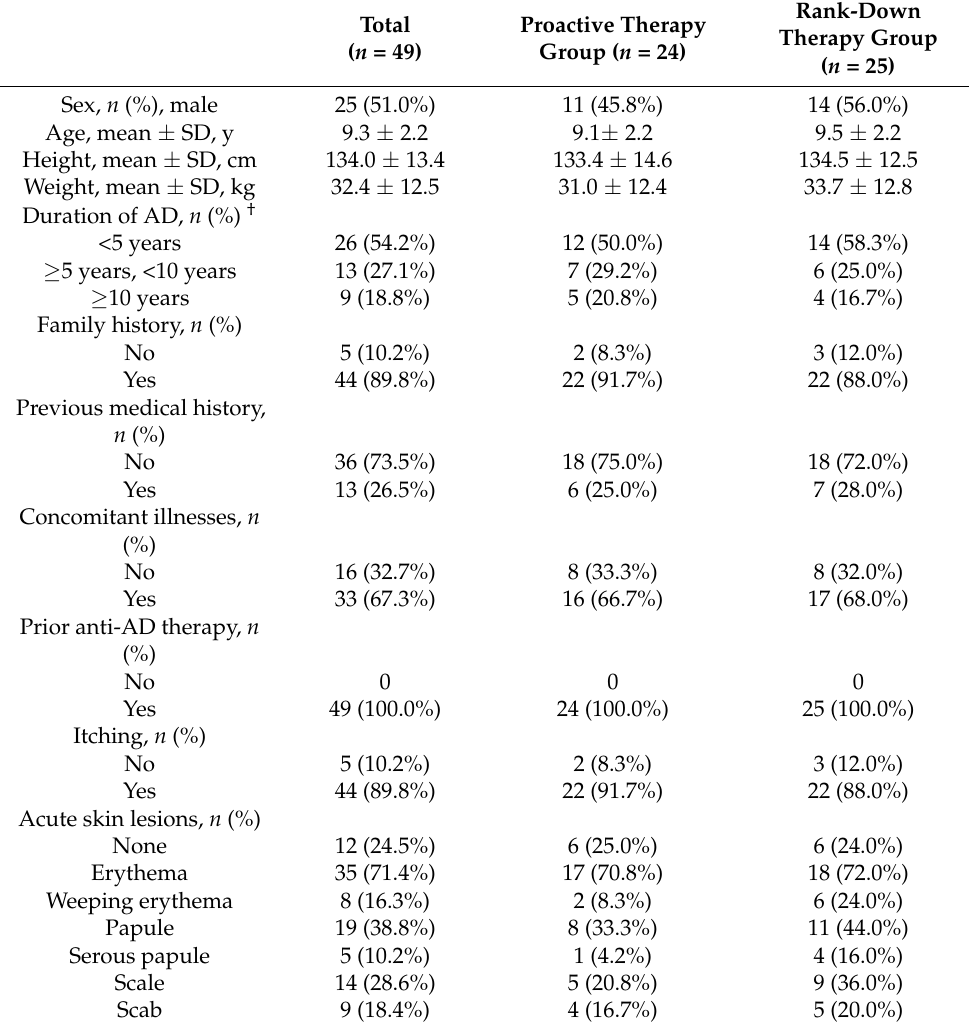
Figure 2. Flowchart of study participants. Abbreviation: FAS, full analysis set. Table 1. Patient characteristics.